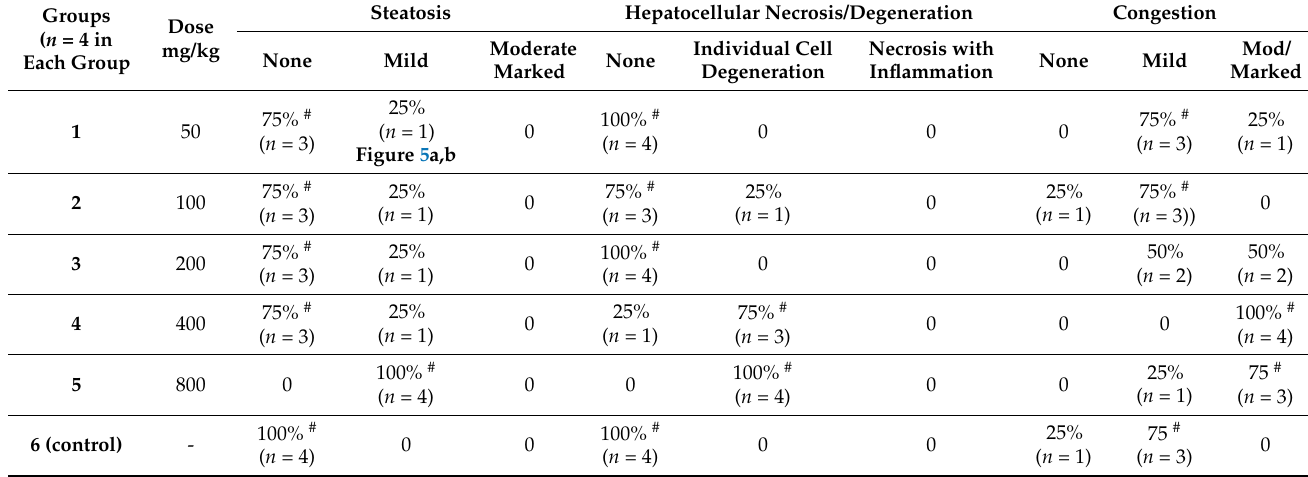
Table 5. Extent of hepatic steatosis, necrosis, and congestion in acute toxicity study ( n = 24). Groups ( n = 4